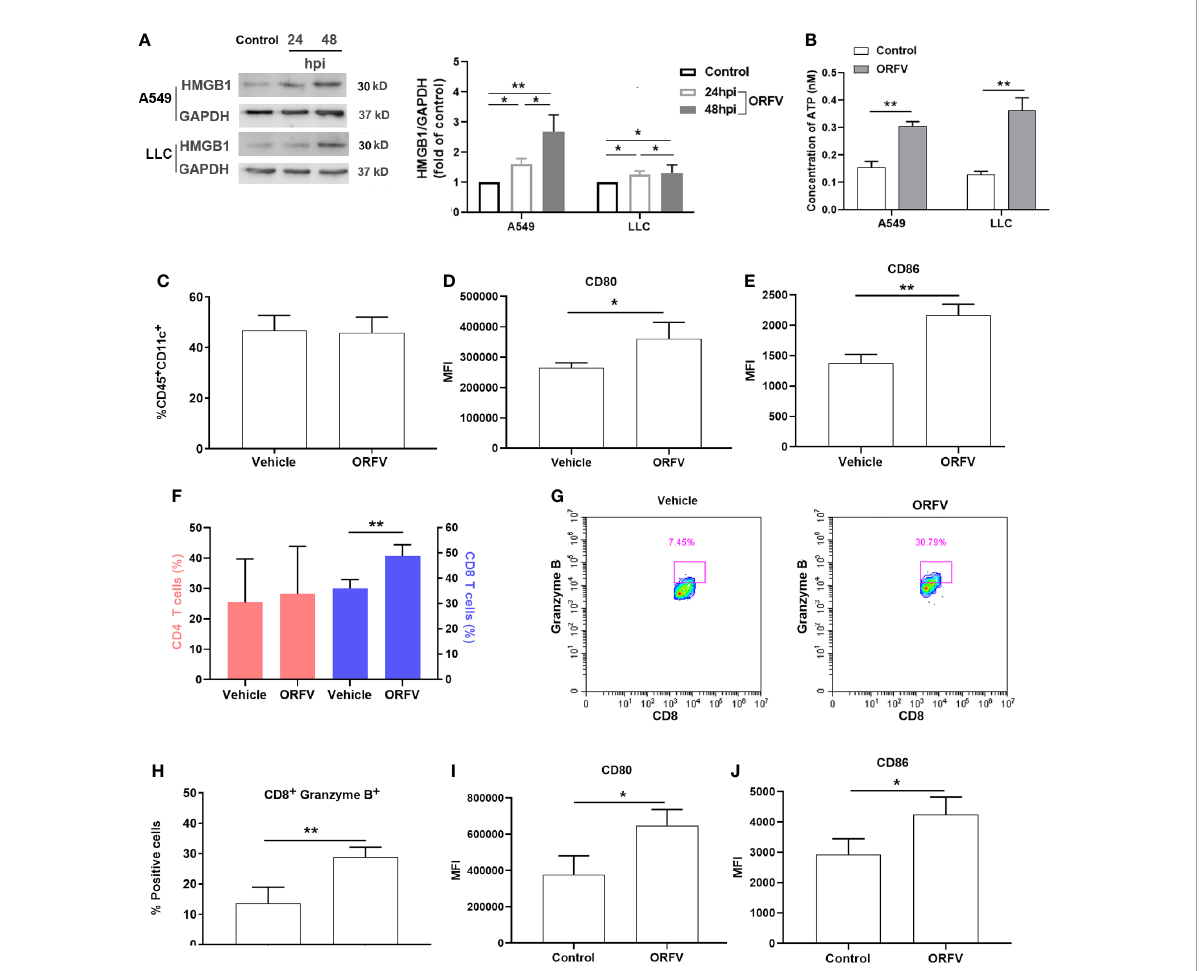
FIGURE 5 ORFV NA1/11 infection promotes the activation of DCs and recruitment of active CD8 T cells. (A) Western blot analysis of the cytoplasmic HMGB1 protein levels in A549 and LLC cells following infection with, or without, ORFV NA1/11 (MOI=5) for indicated time points. Quanti fi cation was performed using Quantity one software. (B) The extracellular levels of ATP in culture supernatants of A549 and LLC cells following infection with, or without, ORFV NA1/11 (MOI 5) were determined using an ATP Assay Kit, according to the manufacturer ’ s protocol. (C) Flow cytometry analysis of the percentages of DCs in tumors tissues. (D, E) Flow cytometry analyses of CD80 and CD86 expression on DCs in tumors tissues of mice, respectively. (F) Flow cytometry analysis of the percentages of CD4 and CD8 T cells in tumors tissues. (G) The percentages of CD8 + Granzyme B + T cells in tumors tissues. (H) Expression of granzyme B of tumor-in fi ltrating CD8 T cells in tumors tissues. (I, J) Flow cytometry analyses of CD80 and CD86 expression on the migrated DCs in vitro . Data are expressed as the mean ± SD of each group